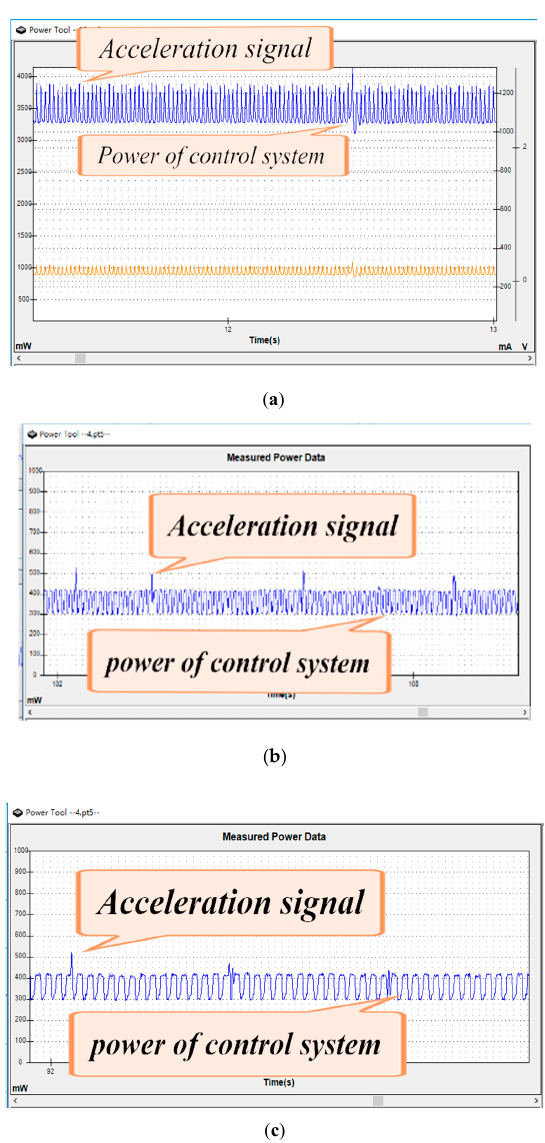
Figure 7. Power of control system. ( a ) Start of the process power consumption at an angle of 30 degrees, ( b ) start of the process power consumption at an angle of 0 degrees, and ( c ) smooth running power.